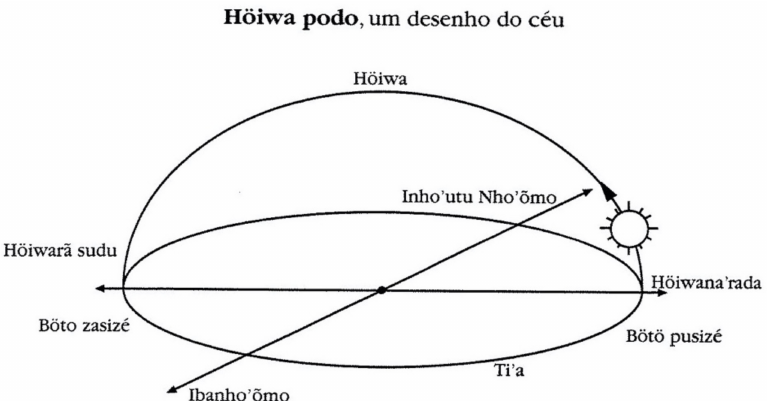
Figure 1. Illustration of the Xavante world concept and forms of spatial orientations. Source: Shaker [11] (p.